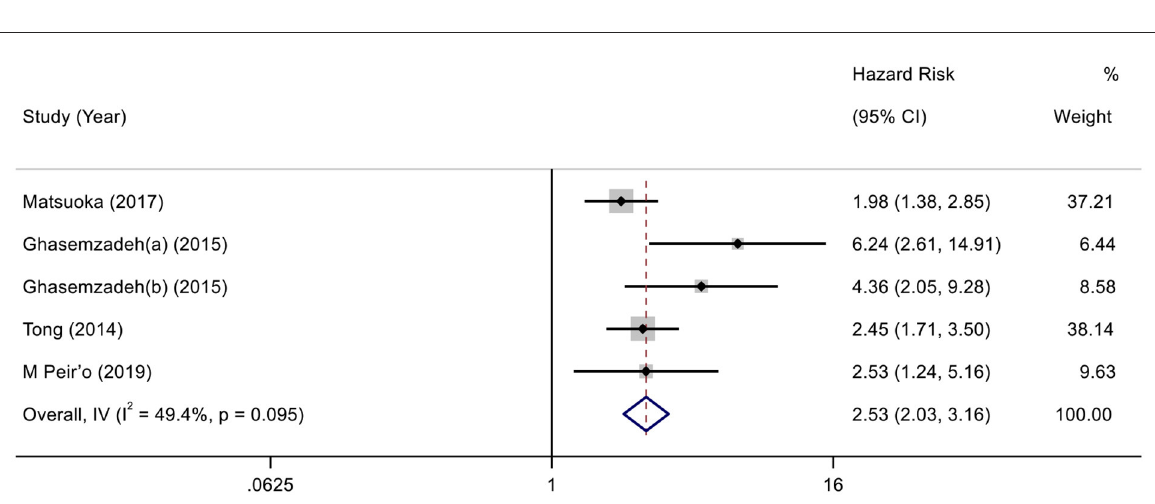
high-risk ischemic cardiomyopathy (33), further supporting the cardioprotective role of